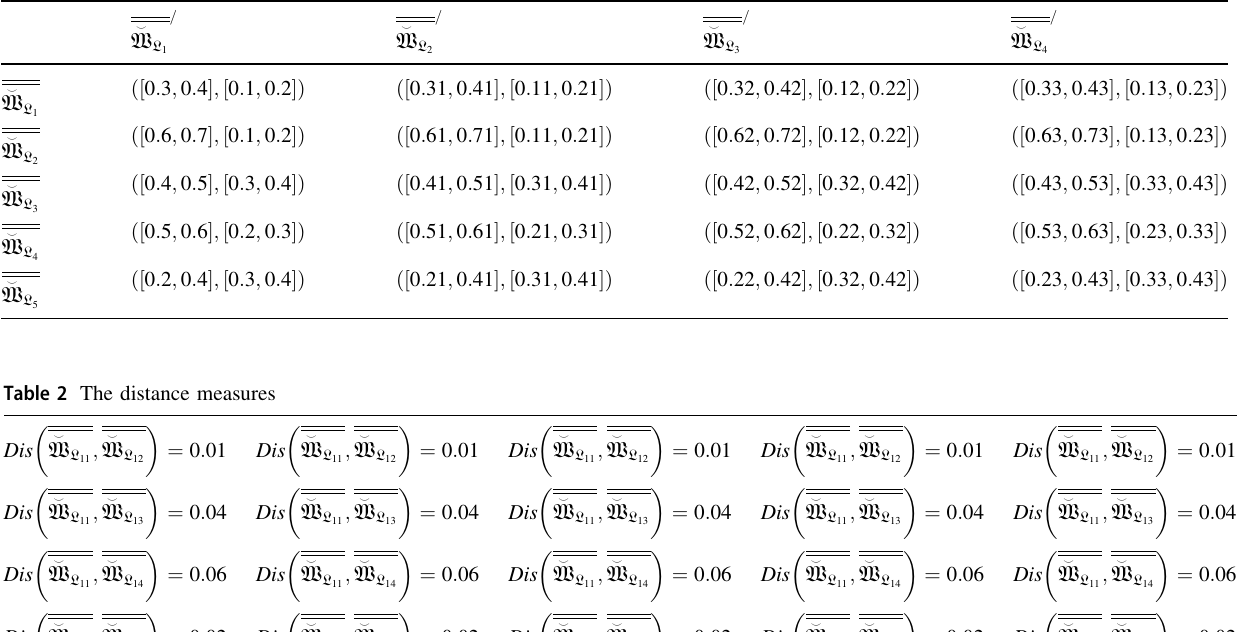
Table 1 Initial IVA-IF decision